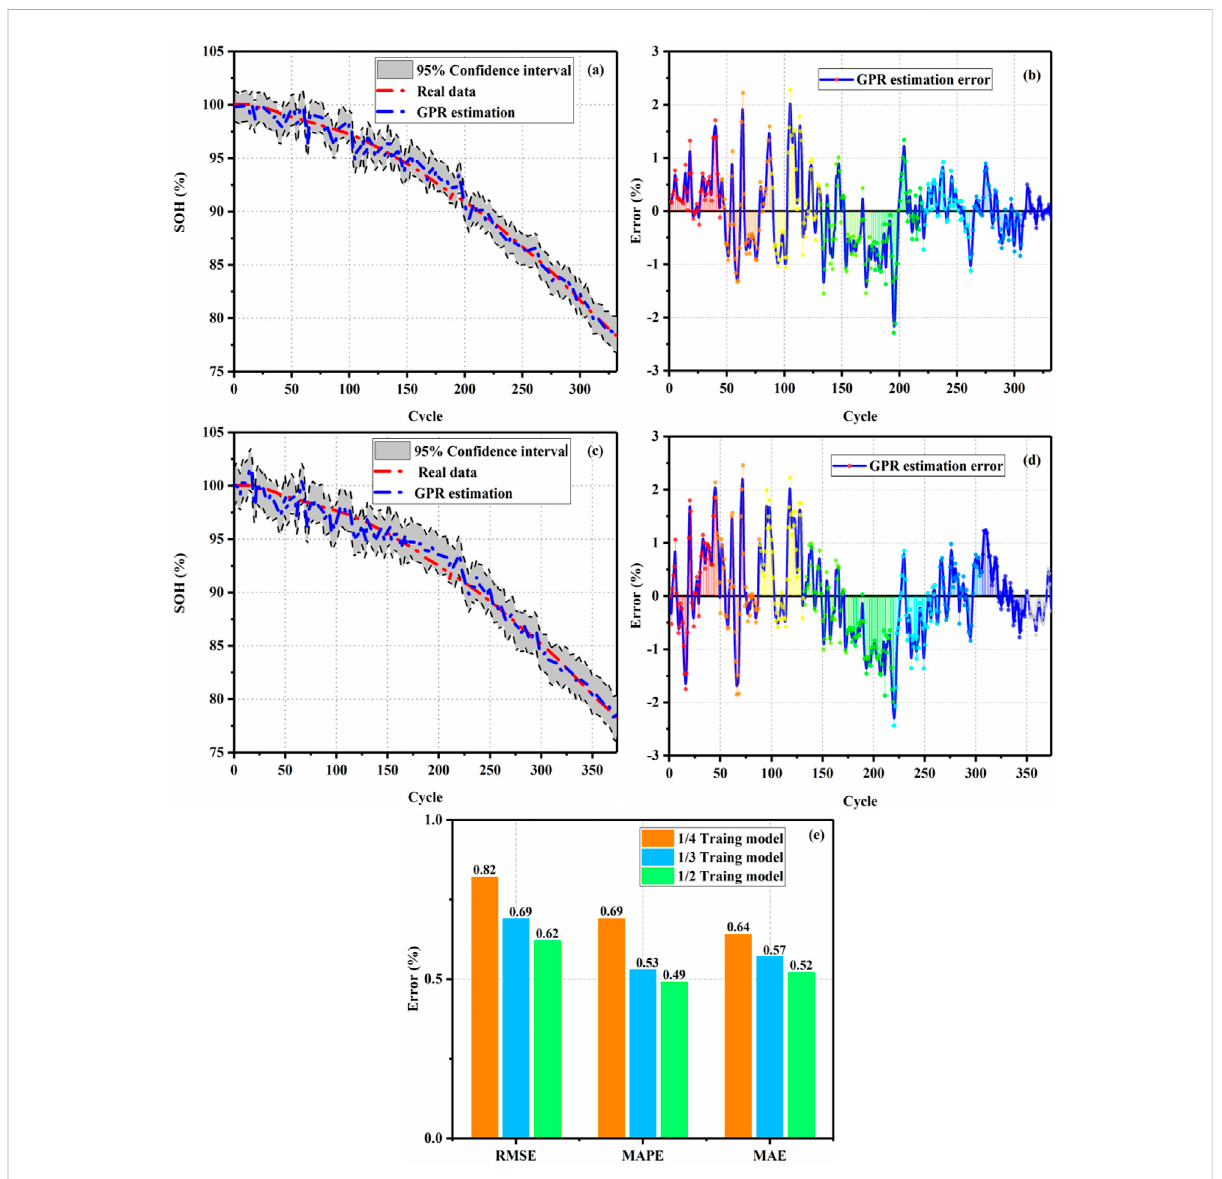
FIGURE 9 (A) SOHestimation under1/3training data, (B) error under1/3training data, (C) SOHestimationunder1/4training data,and (D) SOHestimation under 1/4 training data. (E) Evaluation index for